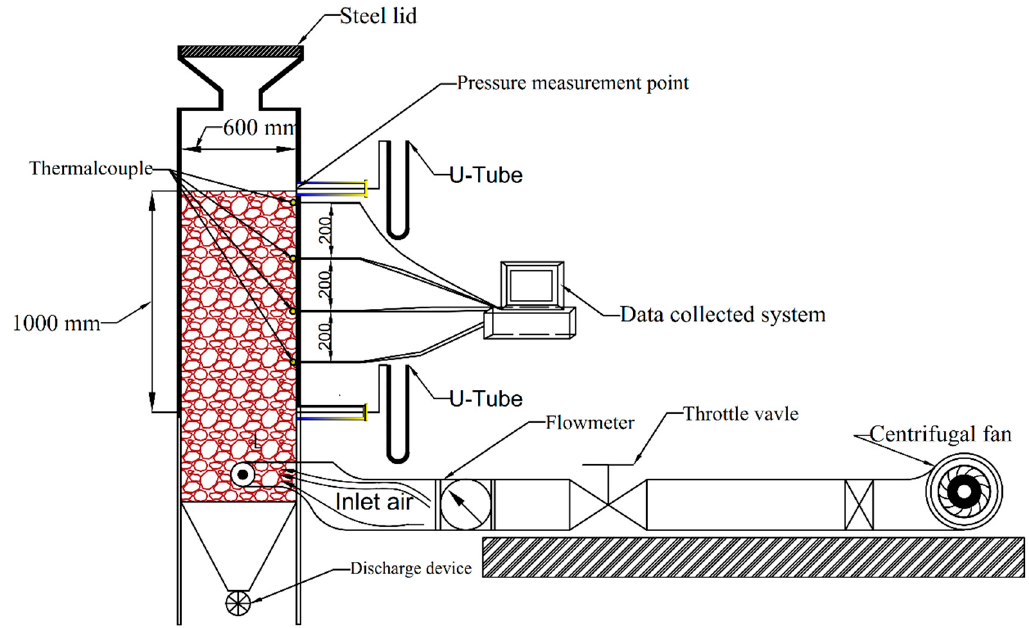
Figure 3. Schematic of the designed vertical sinter cooling bed experiment.